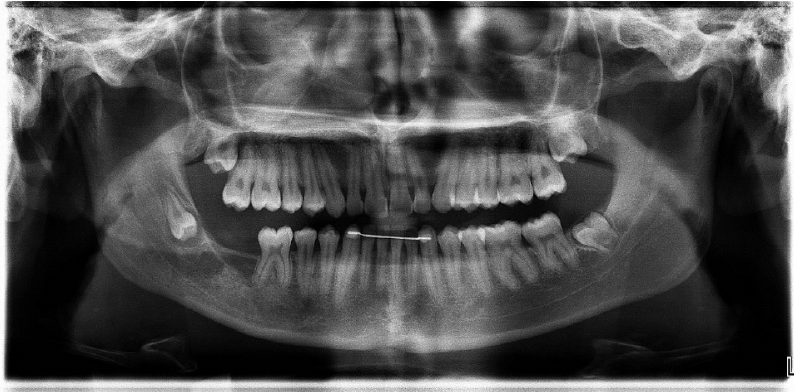
Figure 5. Panoramic radiography one year later: A complete mandible bone healing.